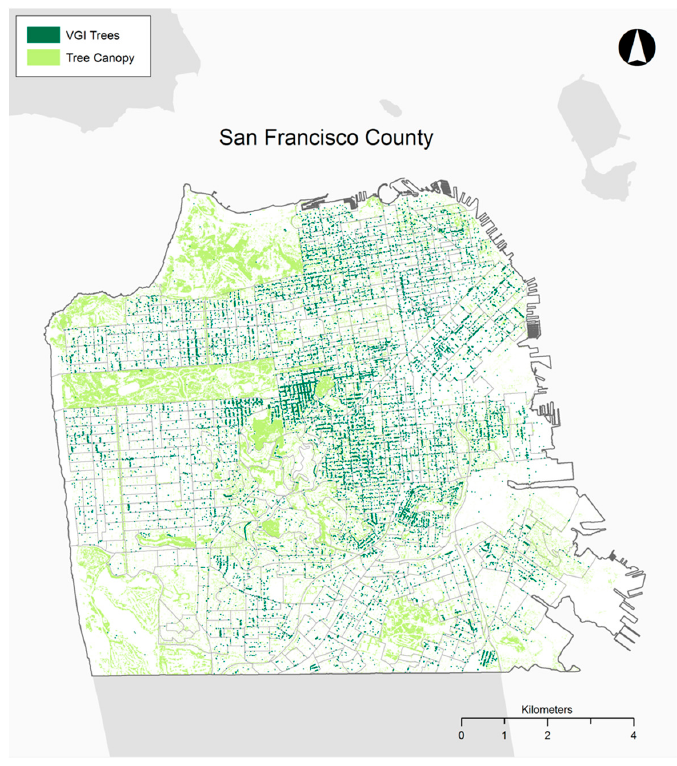
Figure 2. San Francisco tree canopy and all tree points.